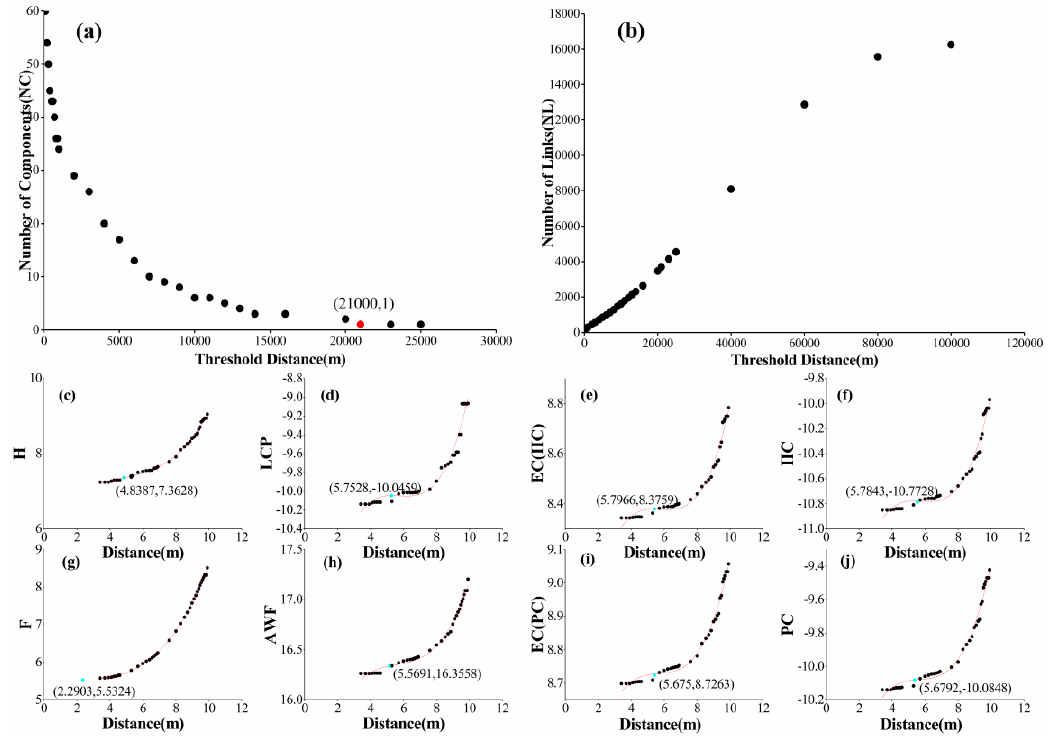
Figure 4. The results for NC ( a ) and NL ( b ), fitting curves and inflection points for eight indices ( c – j ).